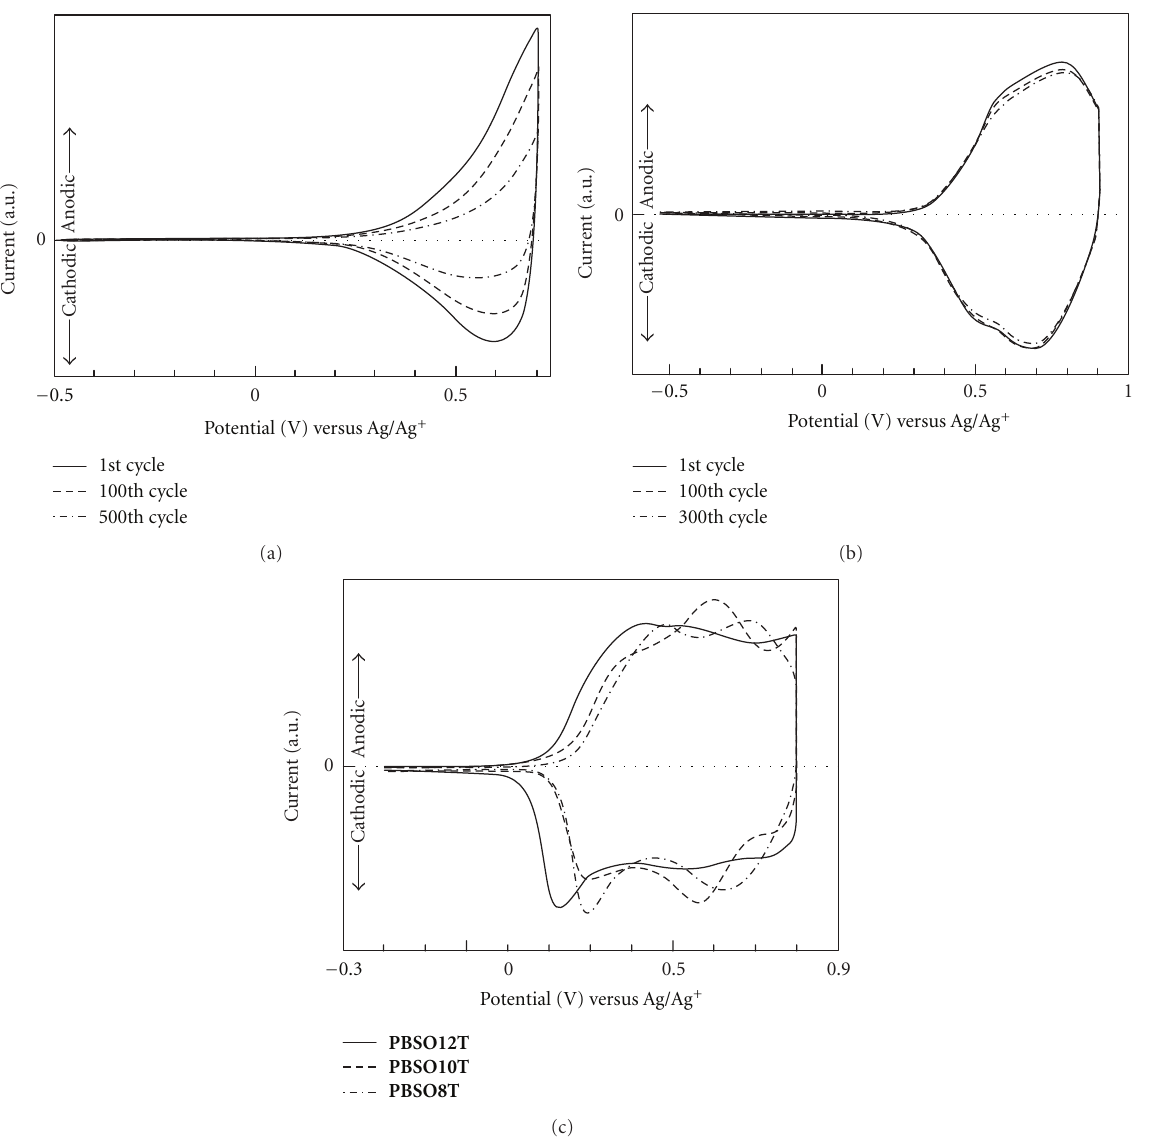
Figure 4: Cyclic voltammograms of (a) PBS6T , (b) PBS8T , and (c) PBSO n T ( n = 8, 10, and 12) films in TEAP (0.1M)/acetonitrile at a scan rate of 50mVs − 1